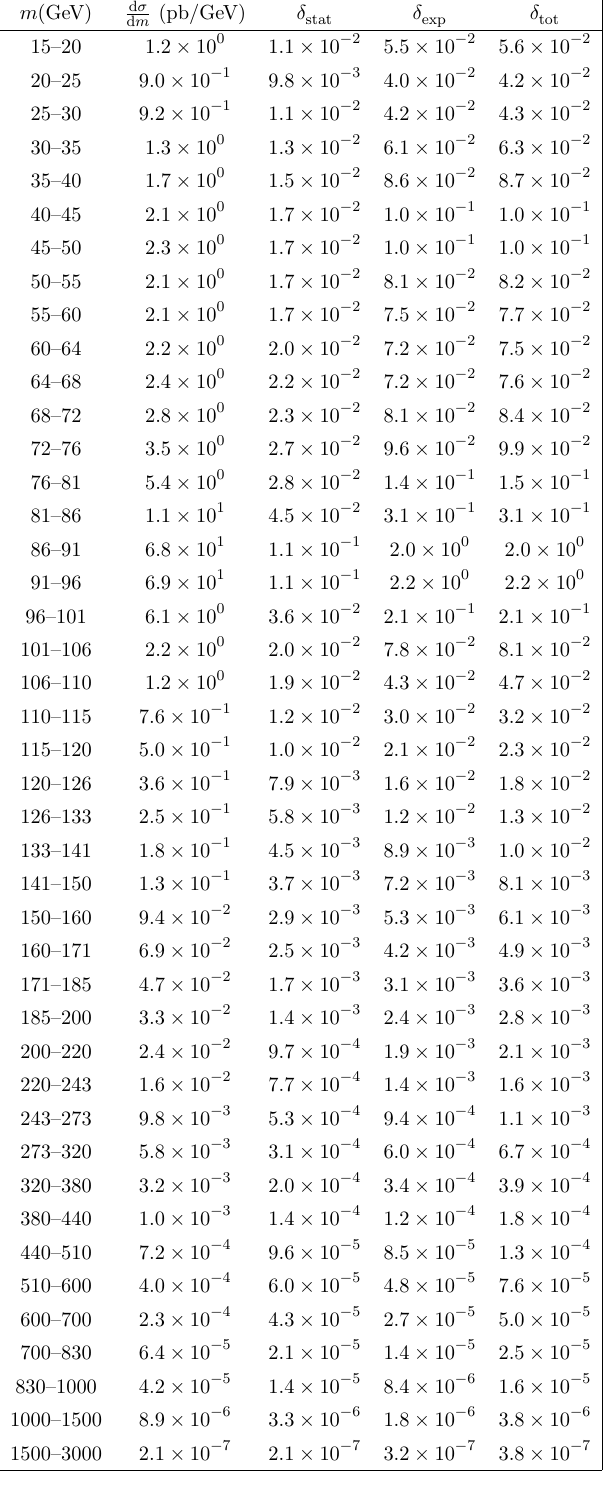
Table 5 . Summary of the measured values of (cid:12)ducial d (cid:27)= d m (pb/GeV) (with no FSR correction applied) in the dimuon channel with the statistical ( (cid:14) ) and experimental ( (cid:14) ) uncertainties stat exp shown separately. Here, (cid:14) is the quadratic sum of the two components. tot